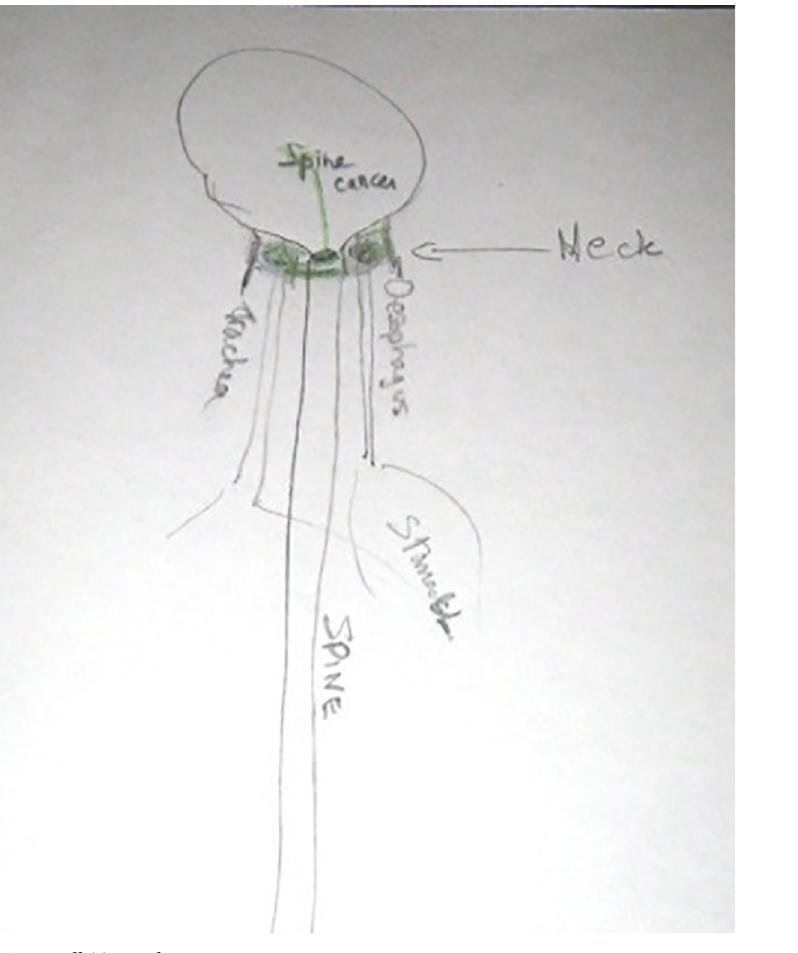
Fig 7. Nell, T1, Neck